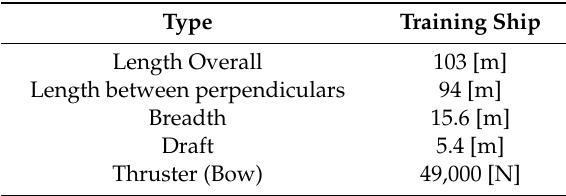
Table 1. The principle ship particulars.